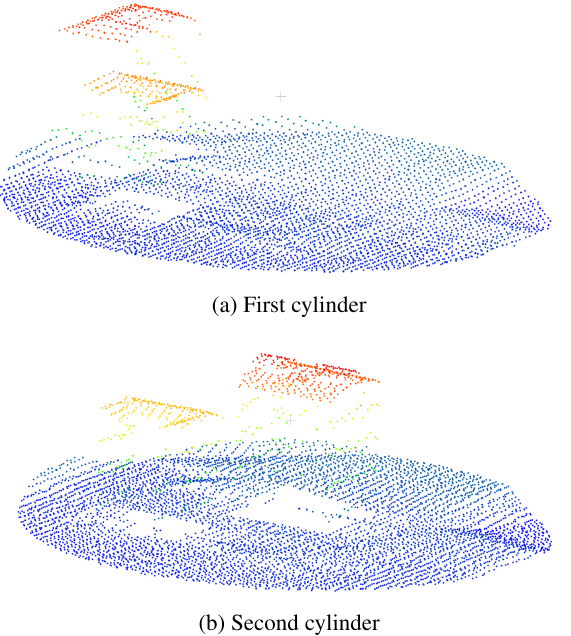
Figure 4. Example of input cylinders: the two input point clouds (a-b) are colorized based on relative elevation.